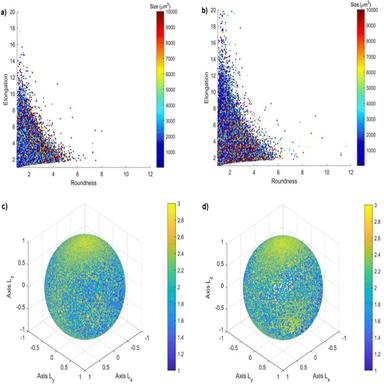
Top, void elongation versus roundness, coloured by label size, for (a) Victrex 3D, and (b) L&V 3D; bottom, unit orientation vector of void primary axis (L), coloured by elongation, for (c) Victrex 3D and (d) L&V 3D.